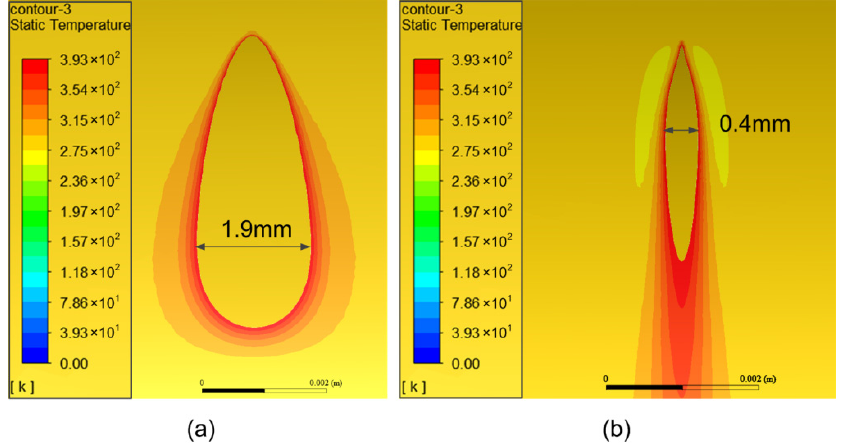
Figure 9. The area distribution of temperature beyond 100 °C: ( a ) rotating speed of 20 rad/s; ( b ) rotating speed of 60 rad/s.